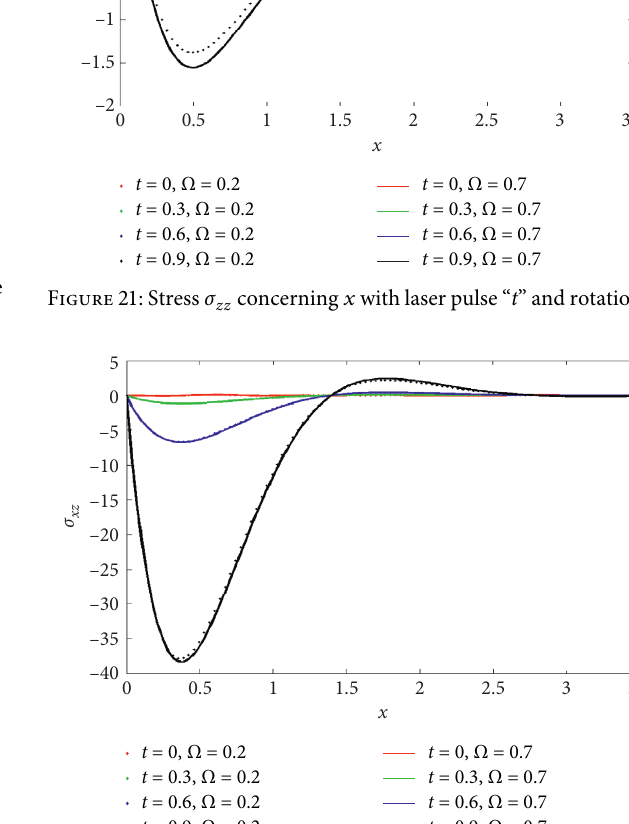
x with laser pulse “ t ” and xz concerning